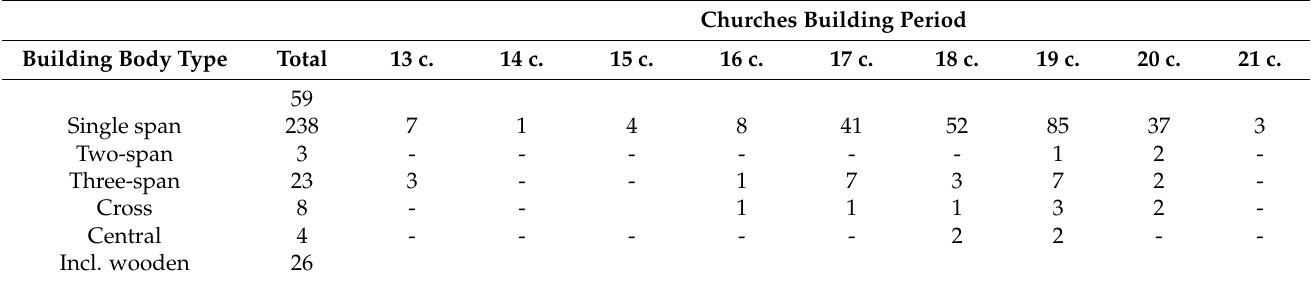
Table 1. The number of churches according to spatial planning and construction period.